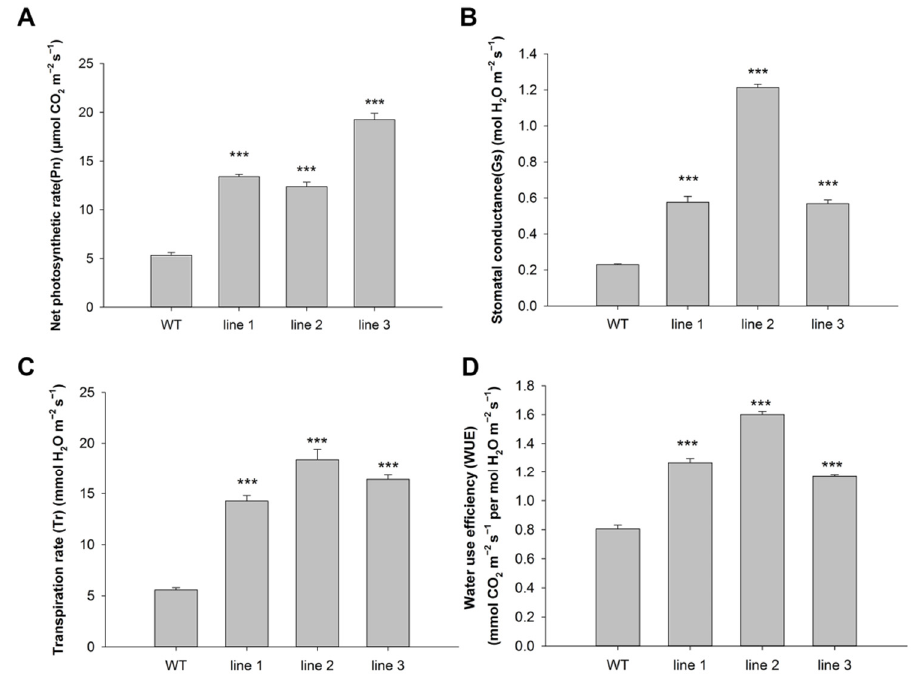
Figure 6. Photosynthetic capacity and water-use efficiency of WT and transgenic alfalfa. ( A ) Net photosynthetic rate (Pn). ( B ) Stomatal conductance (Gs). ( C ) Transpiration rate (Tr). ( D ) Water-use efficiency (WUE). Data were expressed as mean ± SE (n ≥ 30). WT: wild-type alfalfa; line 1, 2, 3: transgenic alfalfa. *** indicate statistically significant differences at p < 0.001.